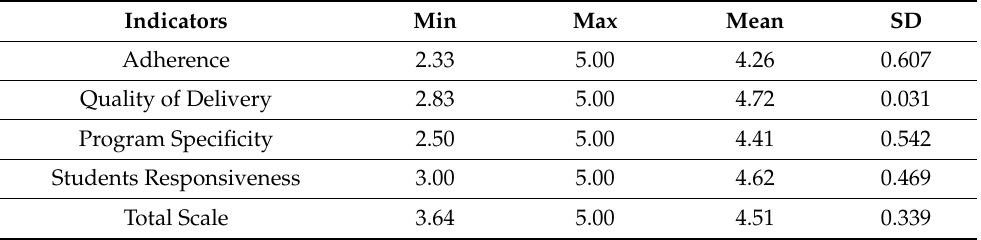
Table 2. Descriptive statistics of each sub-scale and the total scale of the AIFI among 40 CBBS lessons self-evaluated by the PE